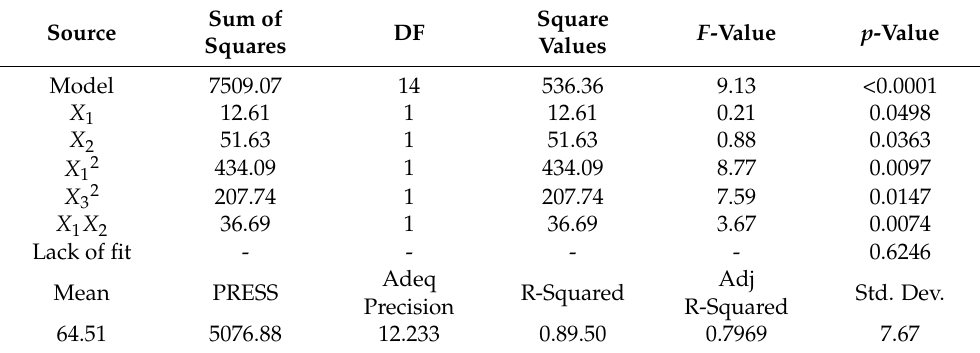
Table 3. ANOVA percentage degradation of orange II